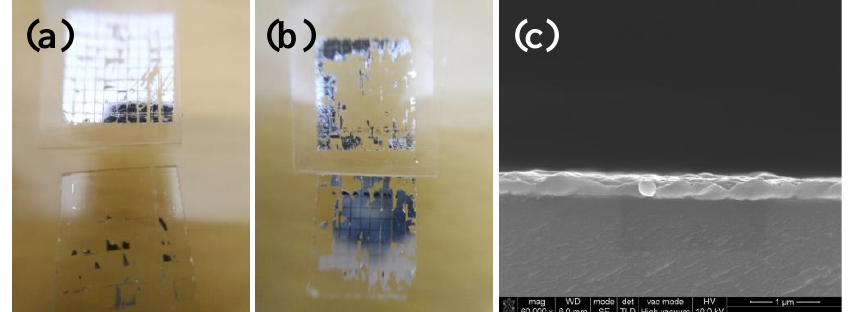
Figure 10. Photos of silver films deposited by DC magnetron sputtering after the tape test: ( a ) Heat cured at 100 °C for 10 min; ( b ) heat cured at 200 °C for 10 min; ( c ) SEM image of cross section of silver films heat cured at 200 °C for 10 min.